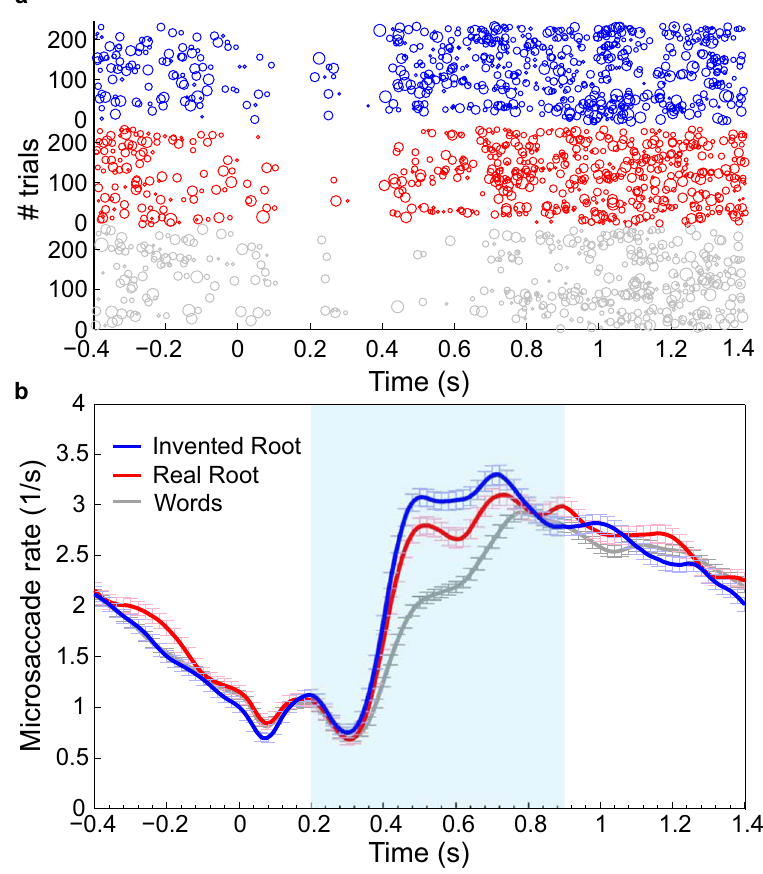
Figure 2. Microsaccade rate modulation. ( a ) Raster plots of microsaccades in a single subject (female, 24y) for Invented-root pseudowords (blue), Real-root pseudowords (red) and Words (gray). Each row represents a single trial. Each circle represents a single microsaccade, with circle diameter proportional to microsaccade magnitude. For visualization, all pseudoword trials (N = 240 trials per condition) but only half of the word trials (N = 240) are displayed. ( b ) Average microsaccade rate modulation curves. Data were averaged, per condition, across all trials and all subjects. Error bars denote standard error of the mean across all trials in each condition. Time zero represents stimulus onset. Shaded blue area illustrates the time window (200–900 ms) used for subsequent